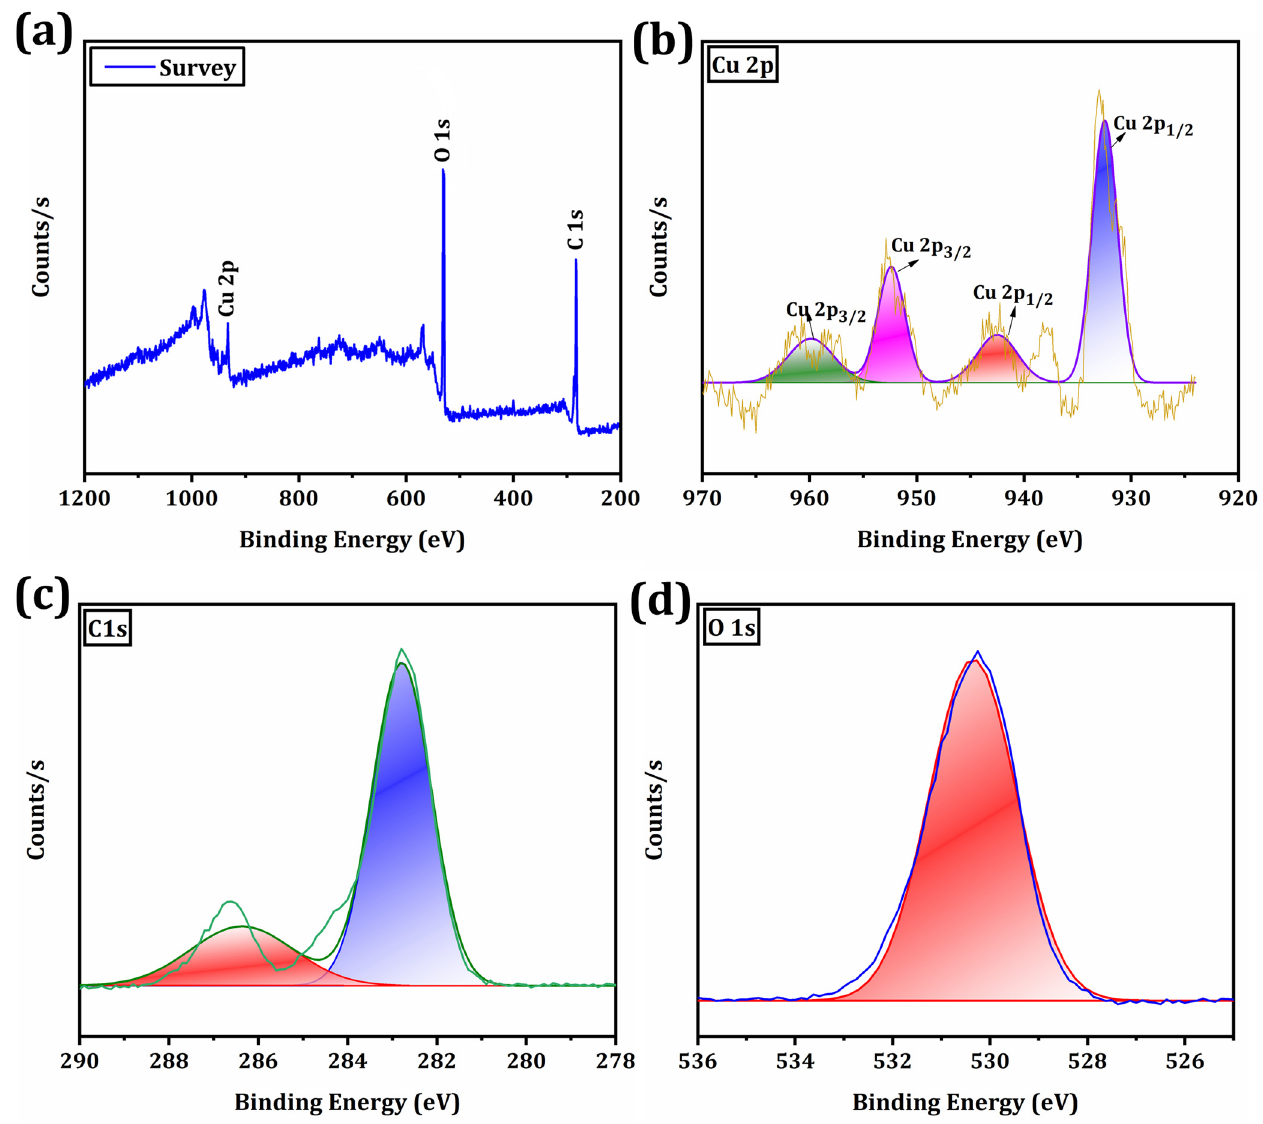
Figure 3. ( a ) Survey spectrum of NWs. ( b – d ) Core-level scan of copper (C 2p), carbon (C 1s), and oxygen (O 1s).